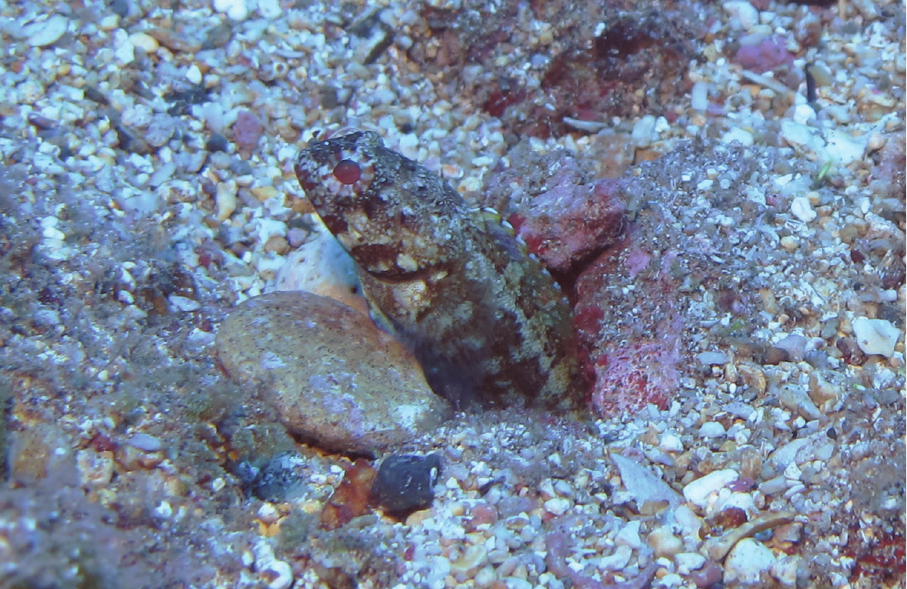
Figure 7. Opistognathus thionyi , in typical habitat, sandy rubble bottom in 13 m at Enseada dos Portu- gueses, Trindade Island, Brazil. Photograph by Thiony